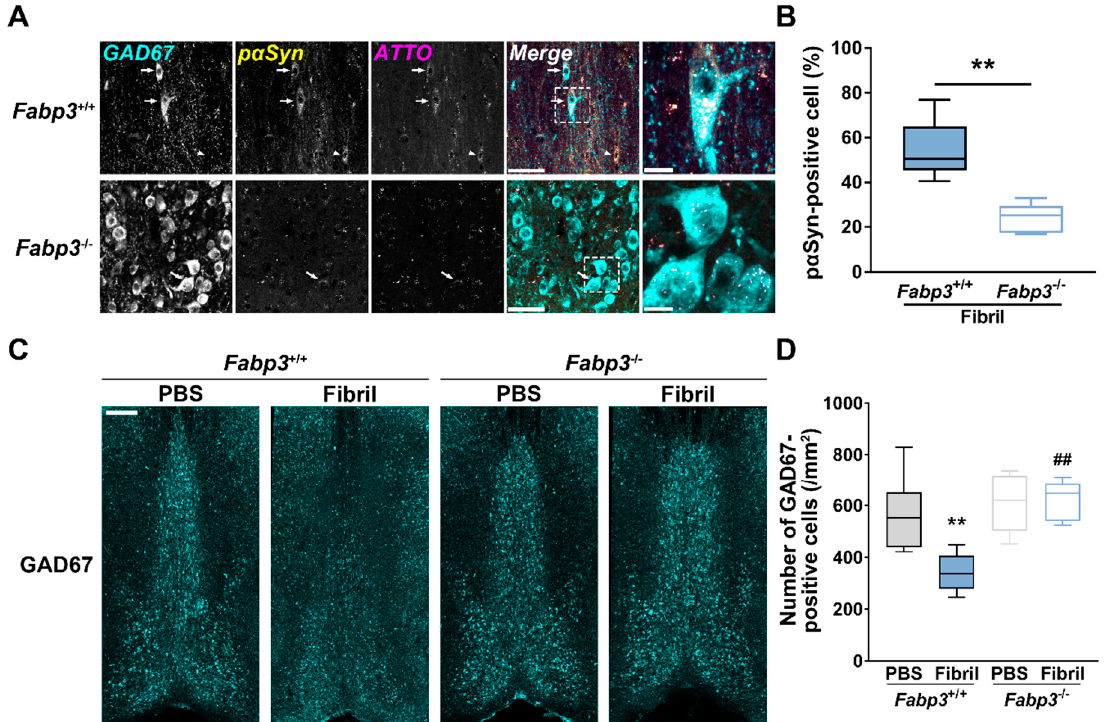
Figure 6. Effects of Fabp3 deletion on p α Syn accumulation and reduction of septal GABAergic neurons after intrastriatal α Syn injection. ( A ) Representative images of p α Syn (yellow) accumulation in GAD67-positive cells (cyan) in the MS/DB, 30 days after the injection. Arrows and arrowheads depict p α Syn-accumulated GAD67-positive and -negative cells, respectively. Scale bar: 50 (merge) and 10 (magnification) μ m, respectively. ( B ) Quantitative analyses of the ratio of p α Syn-positive cells in GAD67-positive cells ( n = 6 per group). ** p < 0.01 between α Syn fibril-injected Fabp3 +/+ and Fabp3 − / − mice. ( C ) Representative images of GAD67-positive cells (cyan) in the MS/DB, 30 days after the injection. Scale bar: 250 μ m. ( D ) Quantitative analyses of GAD67-positive cells ( n = 6 per group). ** p < 0.01 vs. PBS-injected Fabp3 +/+ mice; ## p < 0.01 vs. α Syn fibril-injected Fabp3 +/+ mice.